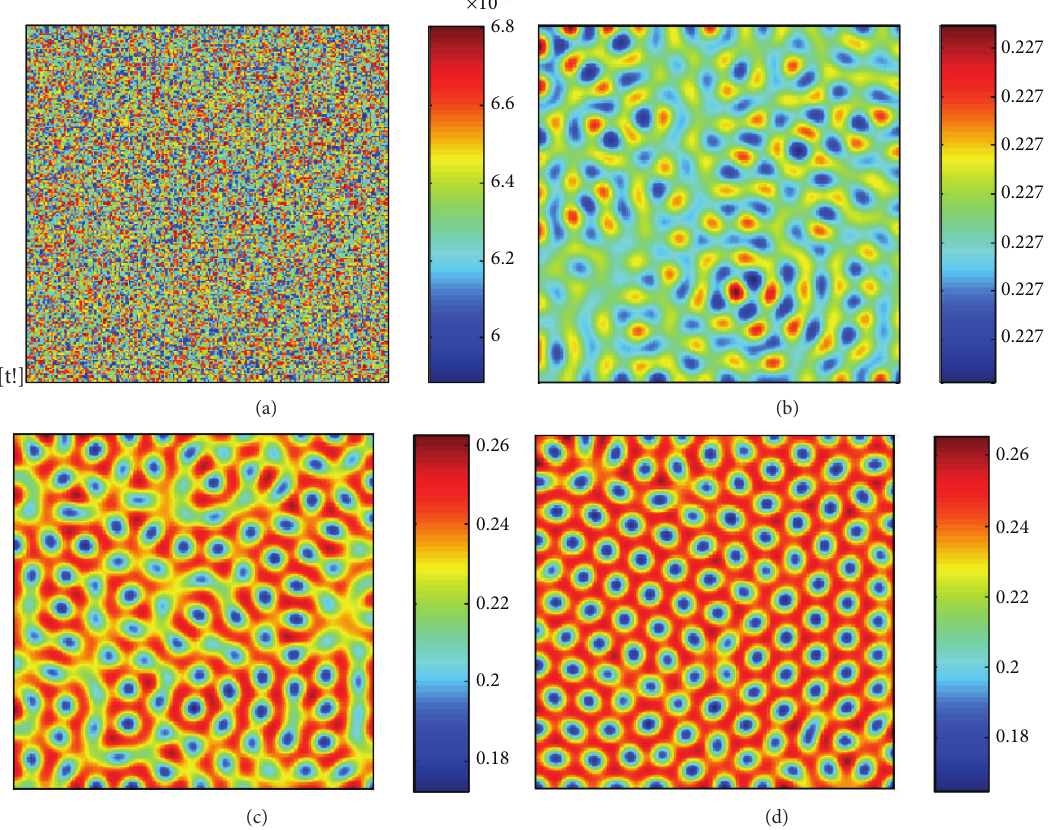
Figure 3: Snapshots of contour pictures of the time evolution of predator in system (3) when 𝑑 2 = 7 and 𝛿 𝐻 < 𝛿 = 0.6 < 𝛿 𝑇 : (a) 0 iteration, (b) 30000 iterations, (c) 100000 iterations, and (d) 200000